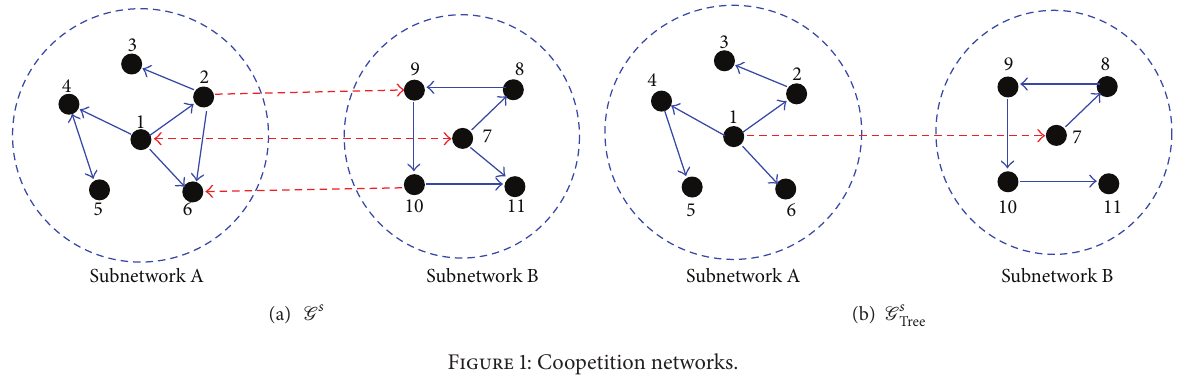
Figure 1: Coopetition